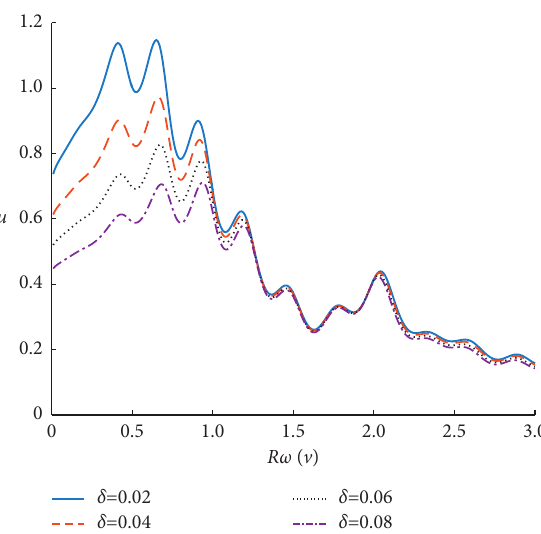
Figure 9: Curves of radial displacement varying with frequency for different thickness of lining.